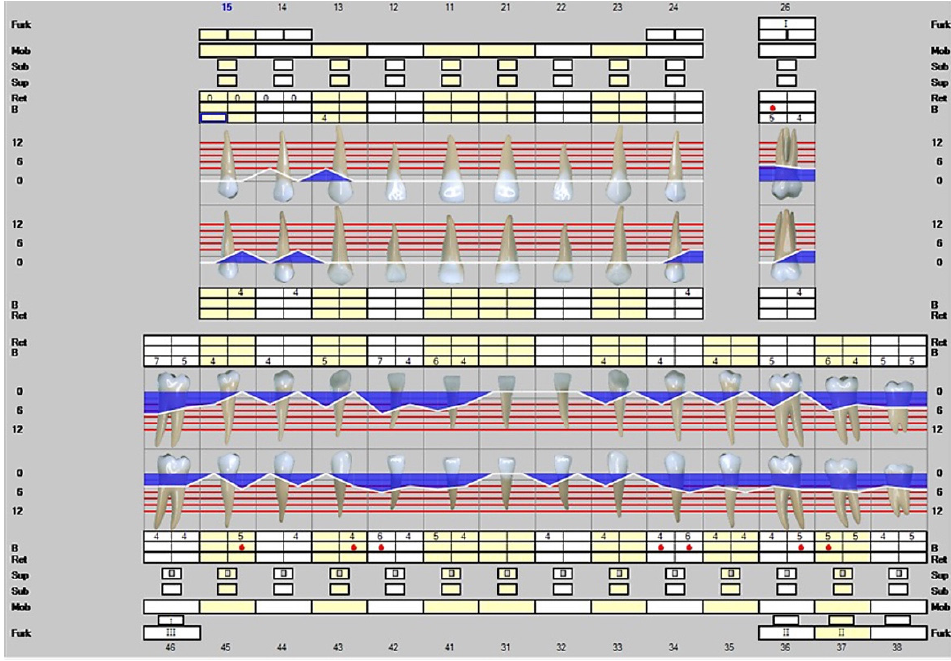
Figure 2. Representation of the clinical situation on 26 April 2021. The white line describes the clinical attachment level and the blue color infected periodontal pockets. The red dots represent a positive result in bleeding on probing.